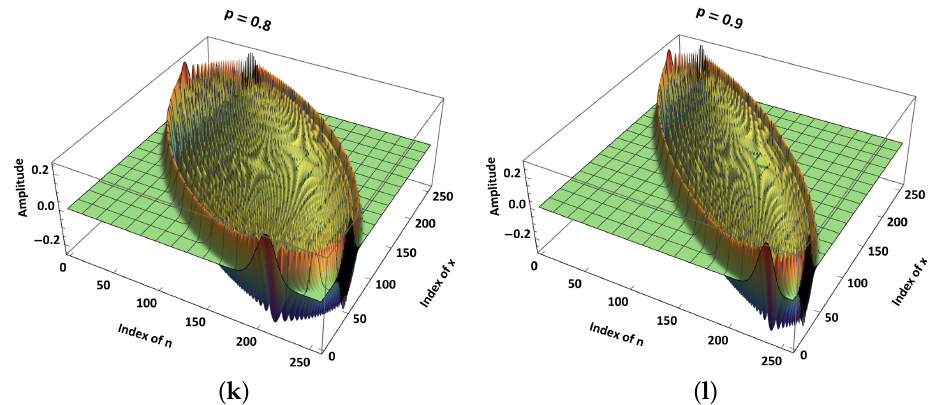
Figure 2. 3D plot of the KPs computed for N = 256 and various values of p : ( a ) p = 0.05, ( b ) p = 0.1, ( c ) p = 0.2, ( d ) p = 0.25, ( e ) p = 0.3, ( f ) p = 0.4, ( g ) p = 0.5, ( h ) p = 0.6, ( i ) p = 0.7, ( j ) p = 0.75, ( k ) p = 0.8, ( l ) p =